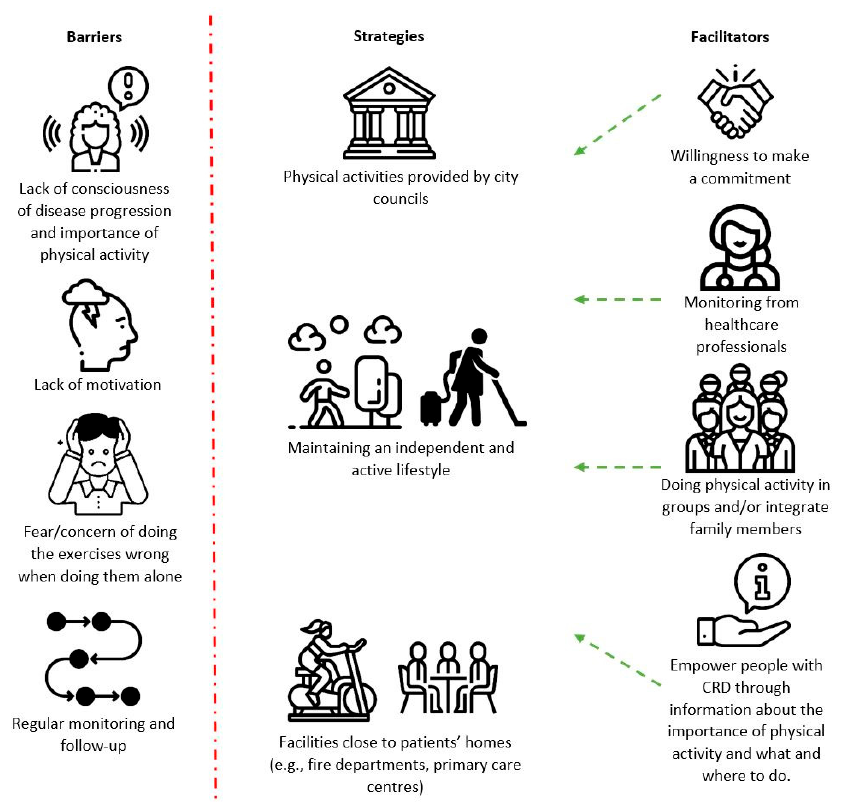
Figure 1. Maintenance strategies, barriers, and facilitators identified by people with chronic respira- tory disease (CRD), informal carers, and healthcare professionals. Images freely downloaded from flaticon.com, accessed on 4 January.